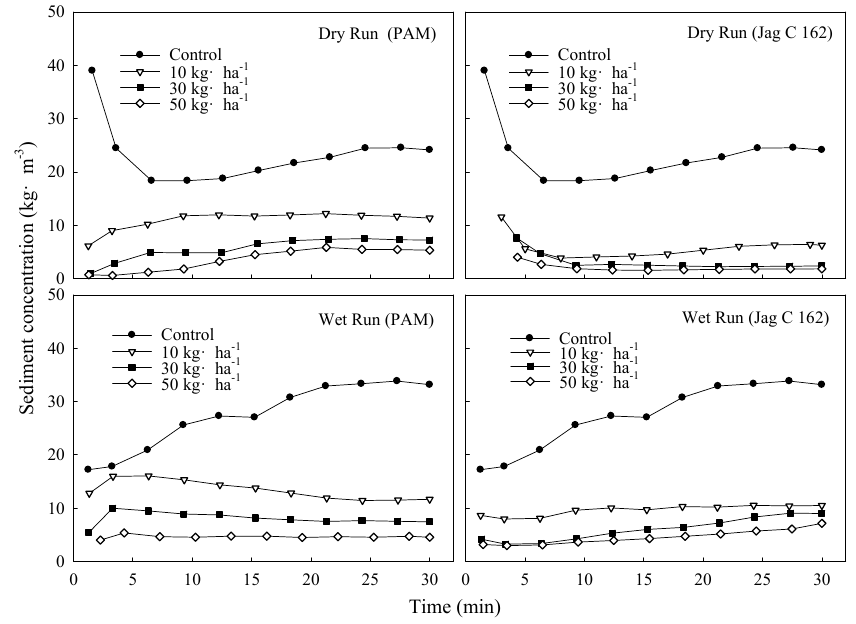
Figure 2. Temporal changes of sediment concentration during dry and wet run after PAM and Jag C 162 treatment. Jag C 162 treatment.